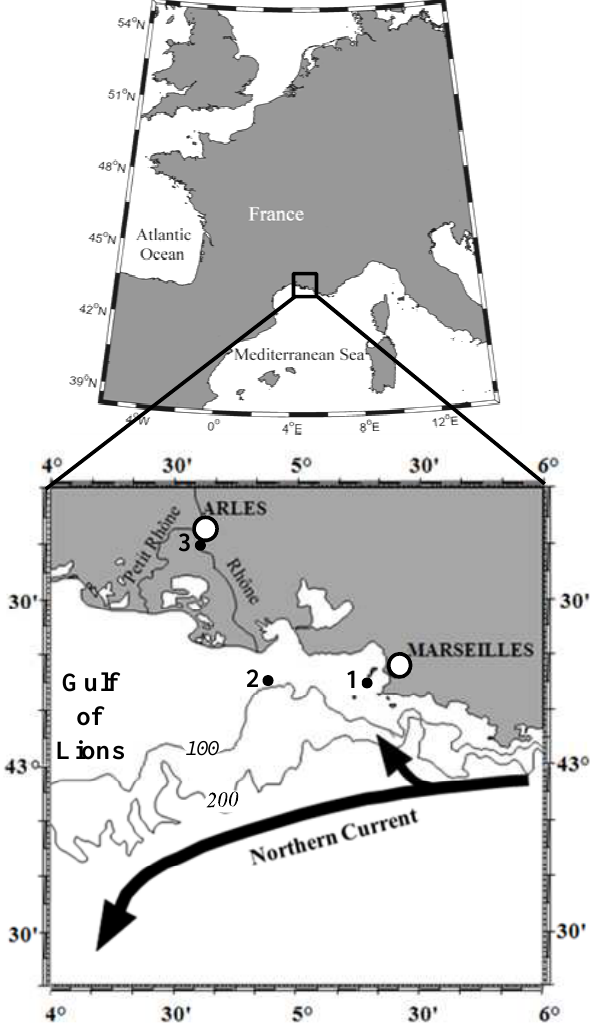
Fig. 1. Map of the Bay of Marseilles marking the location of SOFCOM station (black dot 1) in the Bay of Marseilles, the two Rhône Estuary stations (black dot 2) and Arles station (black dot 3). Distance separating SOFCOM station from Rhône River Estuary is around 40 Km.